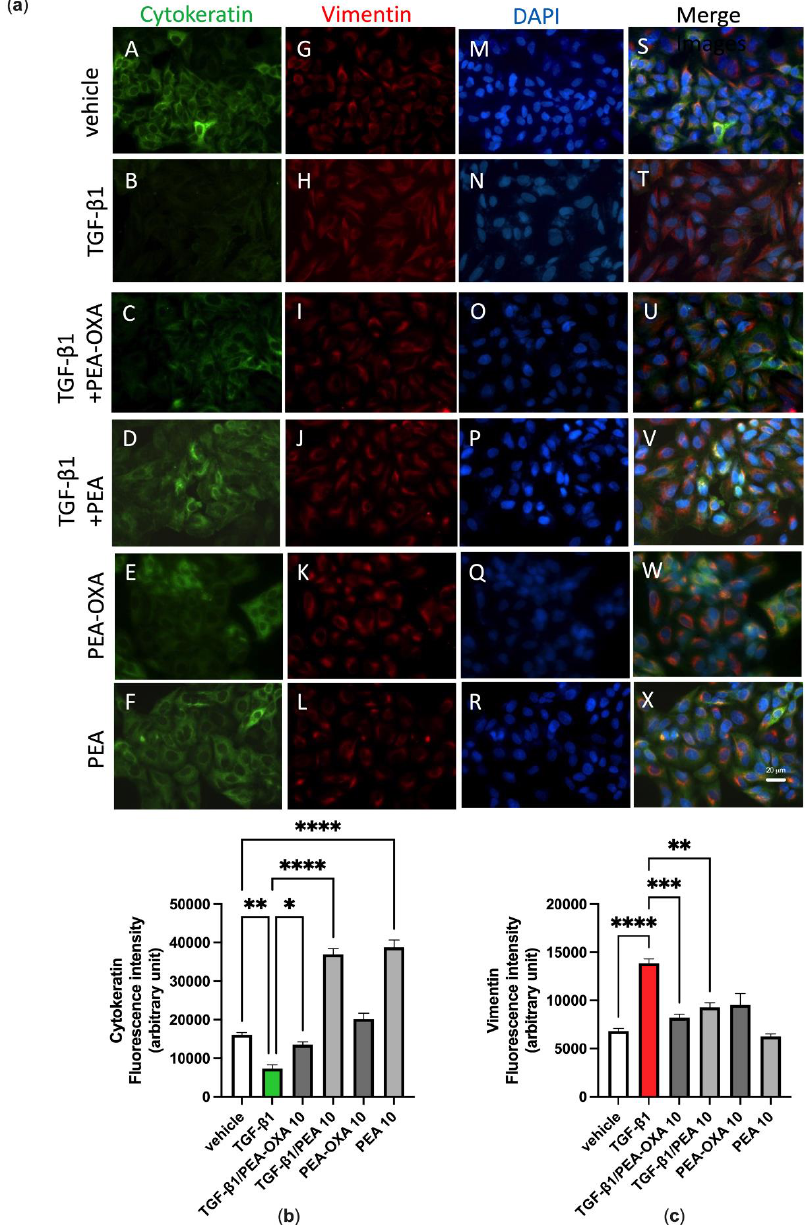
Figure 5. TGF- β 1-induced epithelial–mesenchymal transition in A549 cells as evidenced by immunofluorescence approaches is avoided by the treatment with PEA-OXA or PEA. ( a ) Immunofluorescence staining was examined for the following markers: cytokeratin, an epithelial marker (green fluorescence, panels A–F), and vimentin, a mesenchymal marker (red fluorescence, panels G–L). DAPI staining was included to visualize the cell nucleus (blue fluorescence, panels M–R). In the merged images the co-expression and co-distribution of the markers are visualized (panels S–X). Quantifications of cytokeratin ( b ) and vimentin ( c ). The cells were captured with a 40 × microscope objective (Bar = 20 µ m). Each bar shows the mean ± SEM of independent experiments ( n = 3). The p -values were determined by ANOVA followed by Tukey’s multiple comparisons test. **** p < 0.0001, *** p < 0.001, ** p < 0.01 and * p <